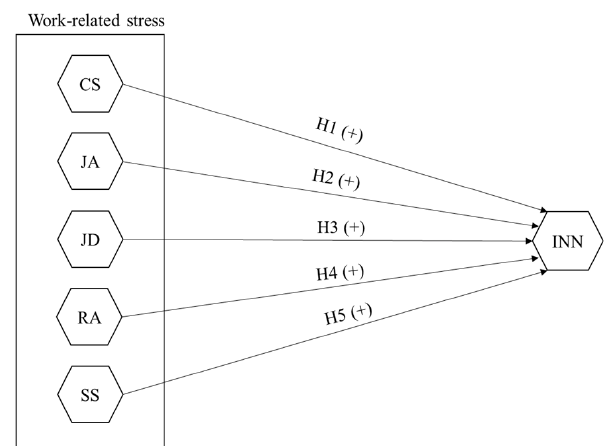
Figure 1. Research model and hypotheses. Notes: CS, Colleagues’ Support; JA, Job Autonomy; JD, Job Demands; RA, Role Ambiguity; SS, Supervisors’ support; INN, Innovation. Source: Own